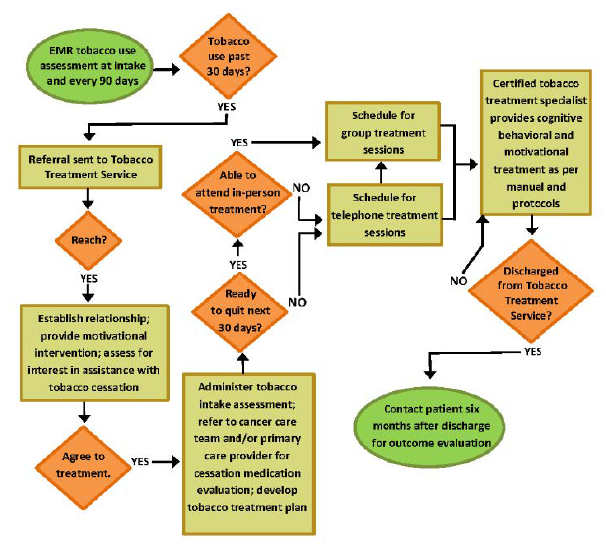
Figure 1. Tobacco Treatment Service workflow.